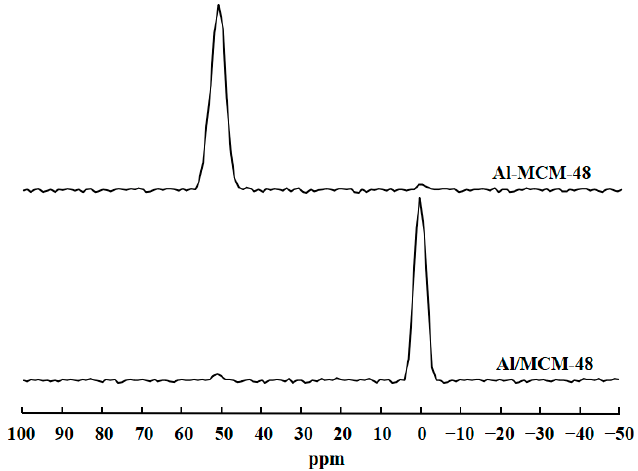
Figure 2. 27 Al MAS NMR spectra of Al-modified MCM-48 materials after calcination at 823 K for 4 h.